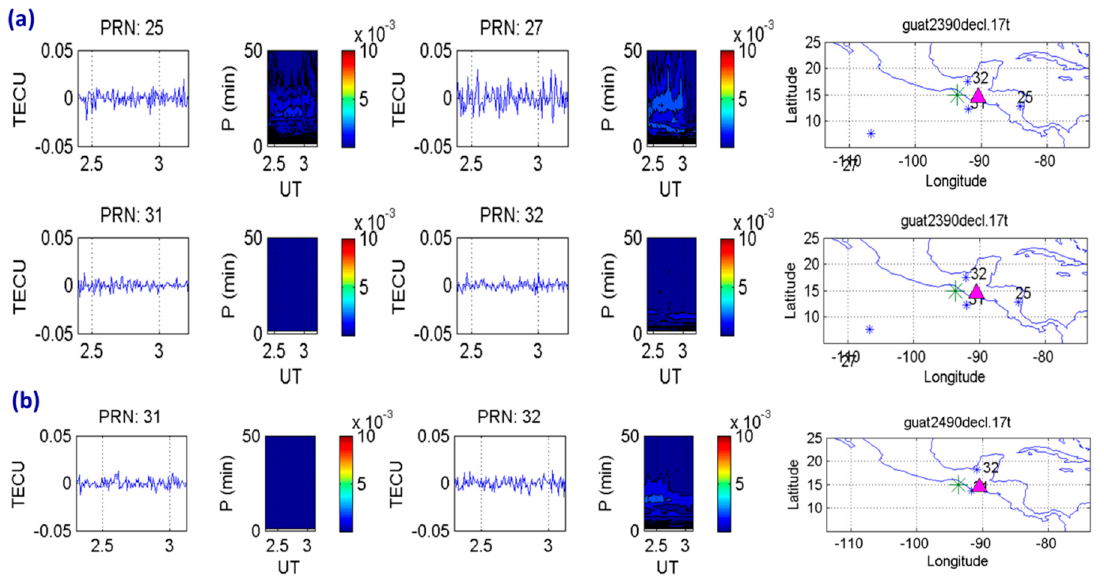
Figure 11. Fluctuations of differential slant TEC obtained from the GUAT station and PRN satellites passing over the earthquake preparation area on seismically “quiet” days: ( a ) 27 August 2017 (DoY 239) (first two upper panels) and ( b ) 6 September 2017 (DoY 249) (lower panel) at 2.5–3.0 UT. Power spectrograms of normalized amplitude are also shown. Maps show earthquake epicenter (green asterisk), GUAT station (pink triangle), number and position of satellite (blue asterisks).